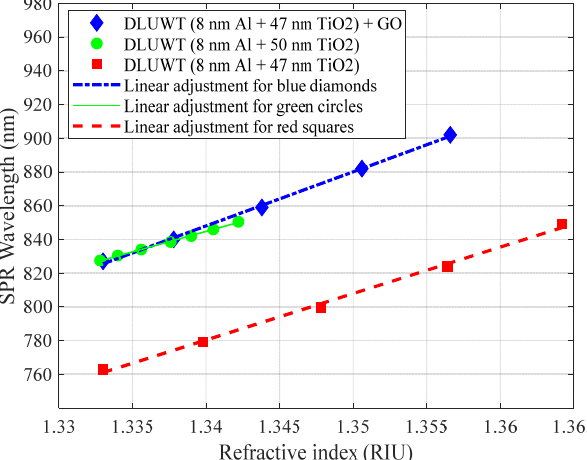
Figure 9. Displacement of the plasmon wavelength due to refractive index variations of the outer medium of a DLUWT with (blue diamonds) and without (red squares) a GO deposition and their corresponding linear adjustments to estimate the sensors sensitivities. It is also shown for comparison (green circles) the curve corresponding to a DLUWT with the resonances in the same wavelength region as those of the GO+DLUWT.